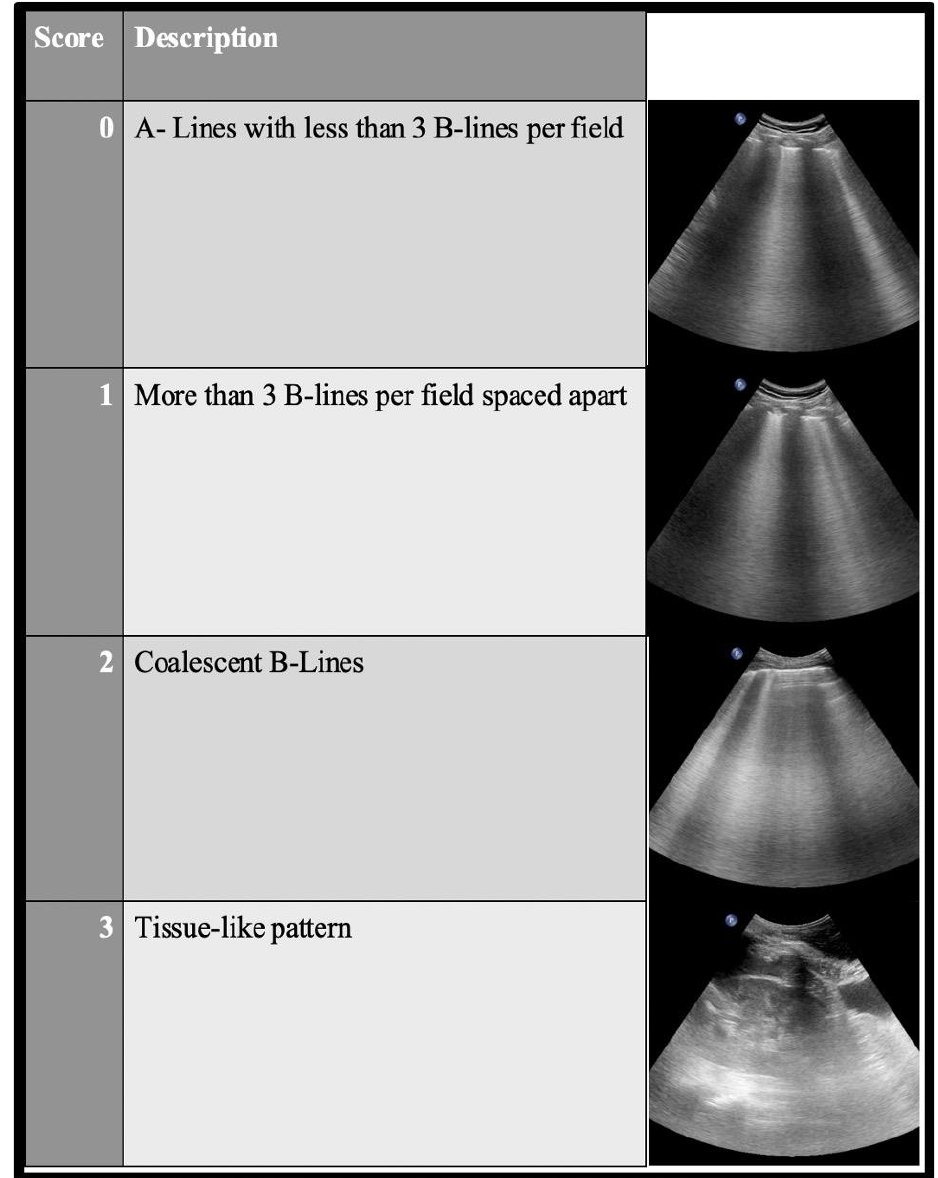
Figure 6. LUS score. Each chest area of interest must be evaluated from 0 to 3. The total score ranges from 18 (BLUE protocol, 3 areas of interest per lung) to 24 (ICC, 4 areas of interest per lung) or 36 (six areas per lung approach used preferentially in the ICU).